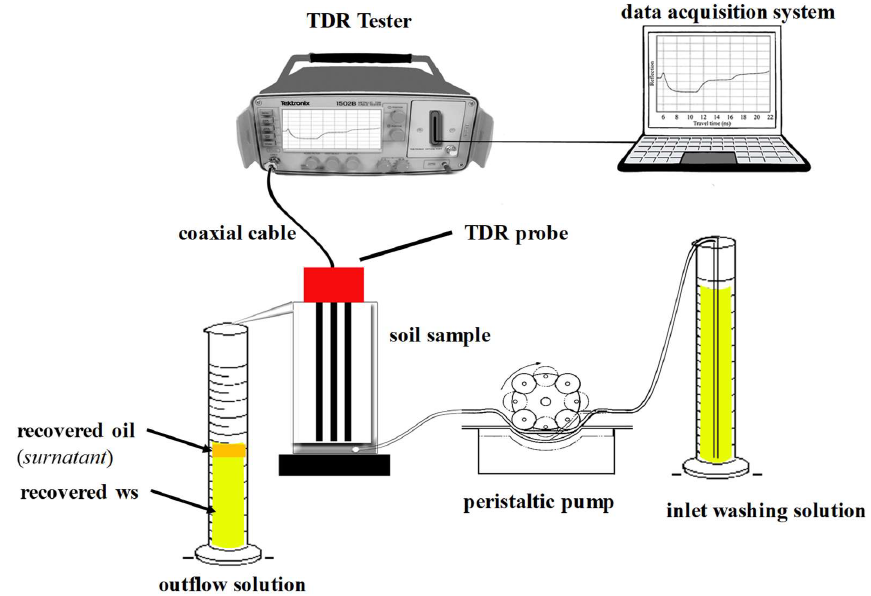
Figure 1. Experimental setup used in the NAPL removal experiments (from Comegna et al.,